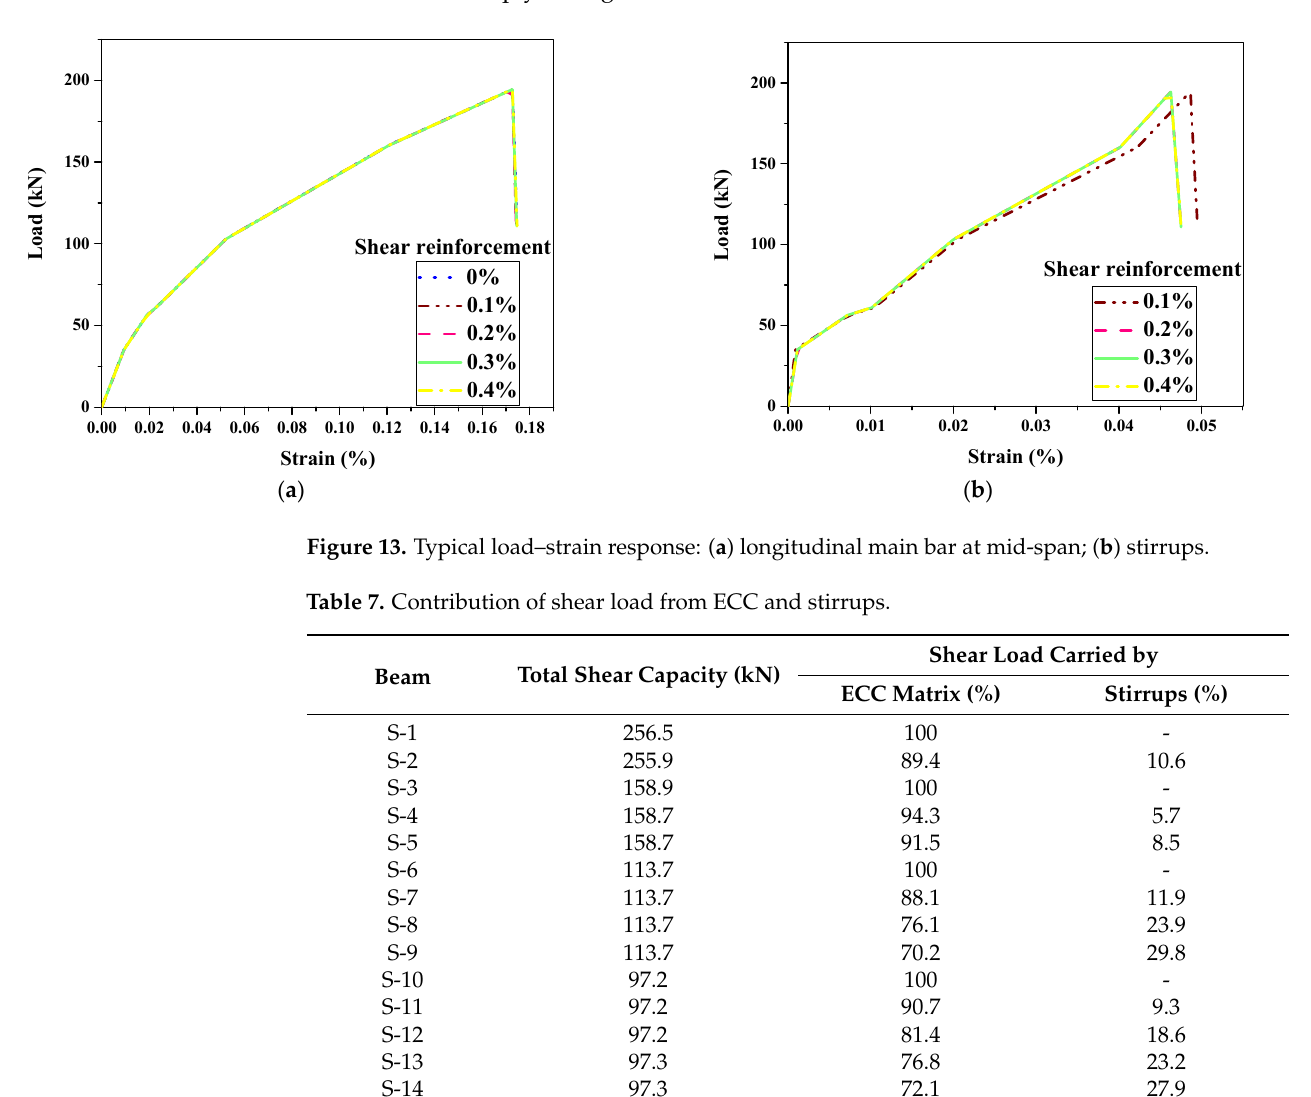
Figure 12. Dimensions of the ECC beam used for parametric analysis (note: all dimensions are in mm).